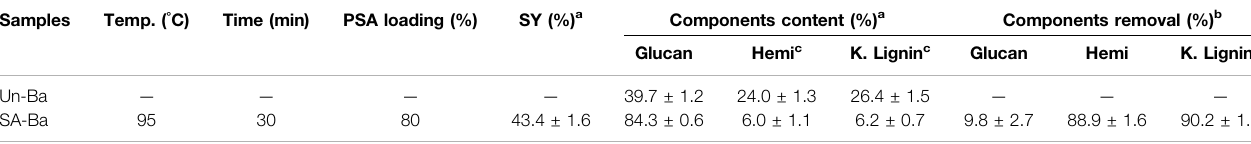
TABLE 1 | The contents and removal of components in untreated bamboo and PSA pretreated solid substrate. Samples Temp. ( ° C)